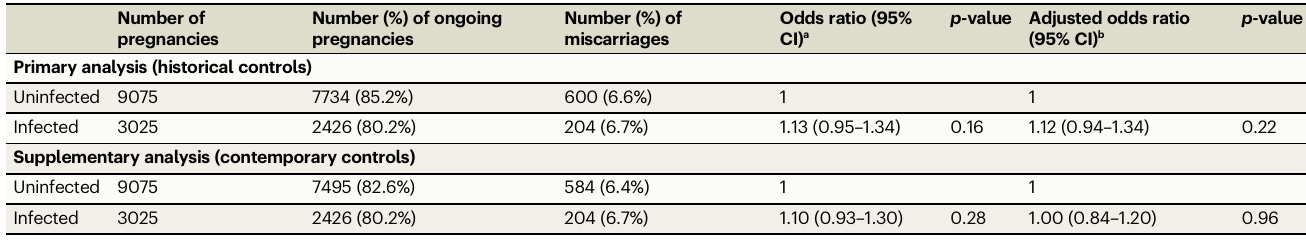
Table 4 | Odds ratios for the association between SARS-CoV-2 infection and miscarriage from multinomial logistic regression models Number of